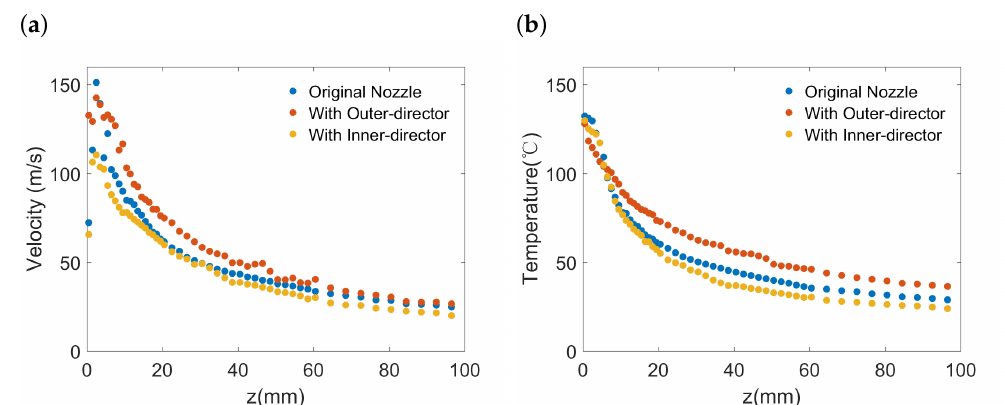
Figure 4. Centreline decay of ( a ) velocity and ( b ) temperature.